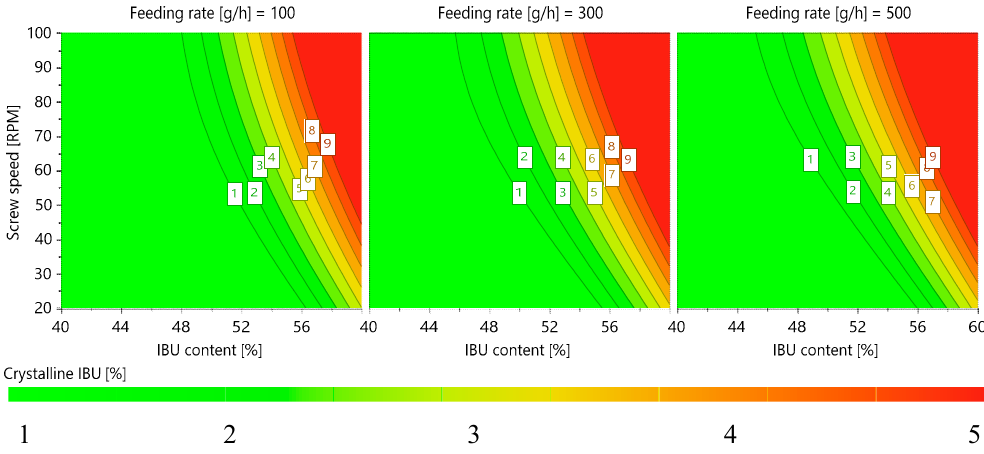
Figure 3. Four-dimensional (4D) contour chart of IBU crystallinity in the samples after the impregnation process.